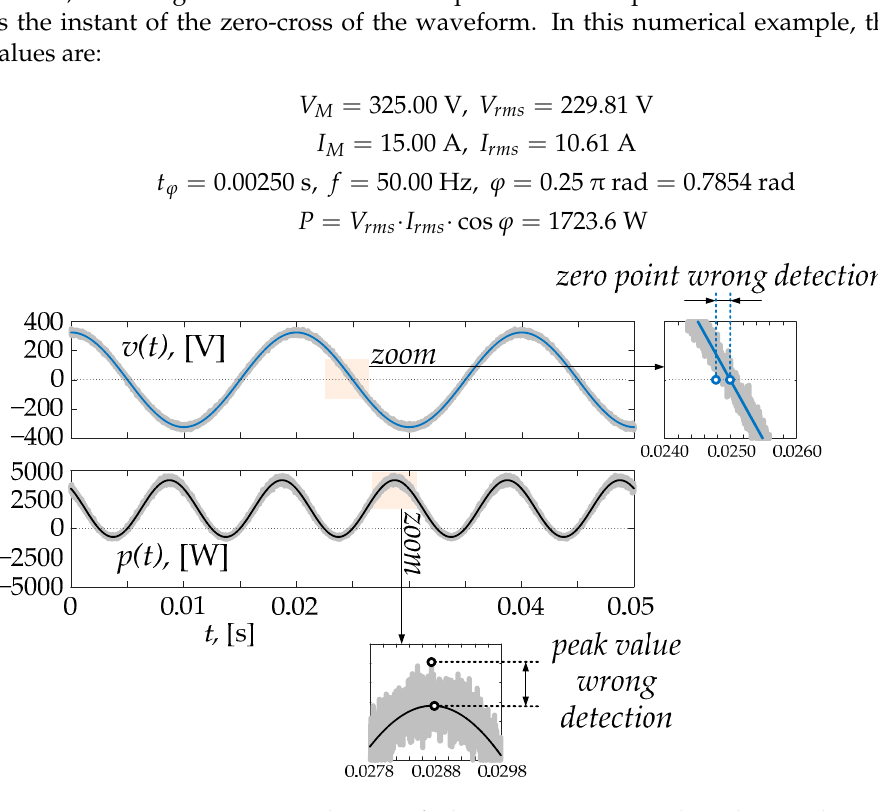
Figure 4. Measurement issues in the case of white Gaussian noise, where the signal-to-noise ratio is 30.